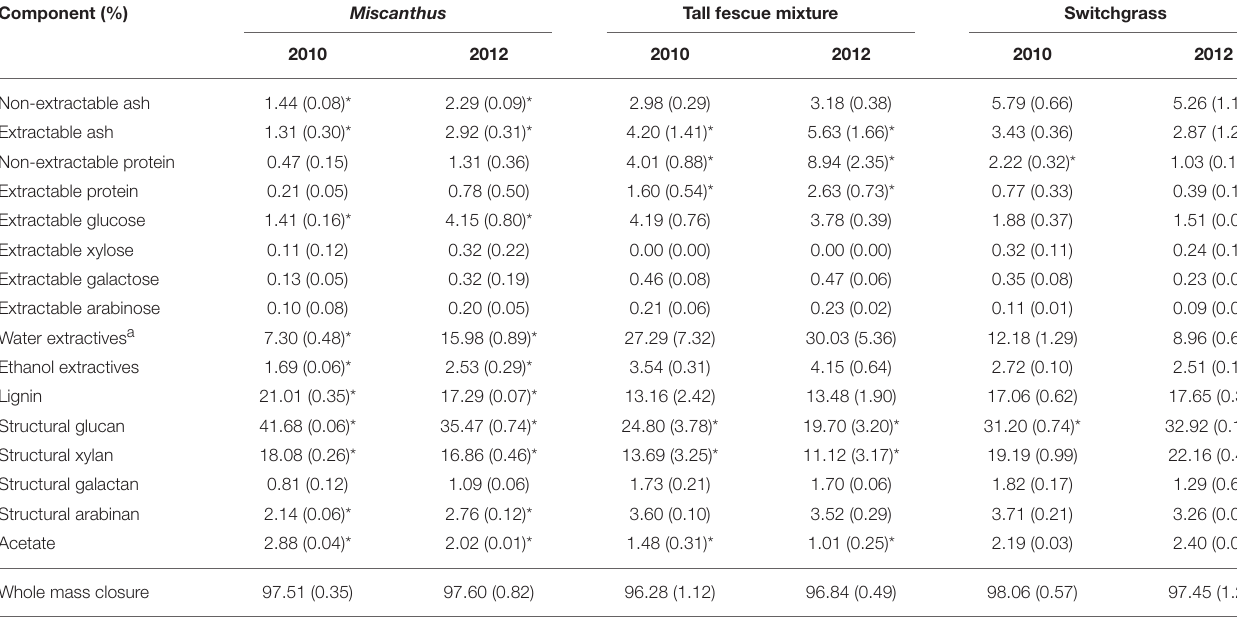
TABLE 3 | Percent of each compositional-analysis component for Miscanthus , the tall fescue mixture, and switchgrass grown in 2010 and 2012 [ n = 3; mean (1 SD